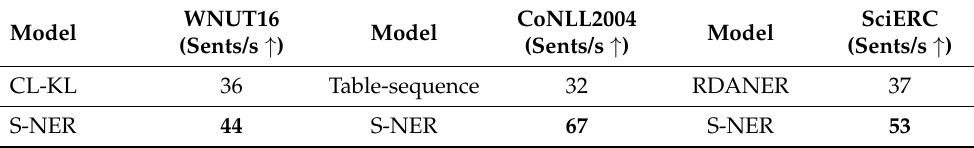
Table 8. Comparisons of the model training speed between S-NER and sequence labeling-based NER models. ↑ denotes that a larger value means a faster speed. Bold values denote the best results. Model